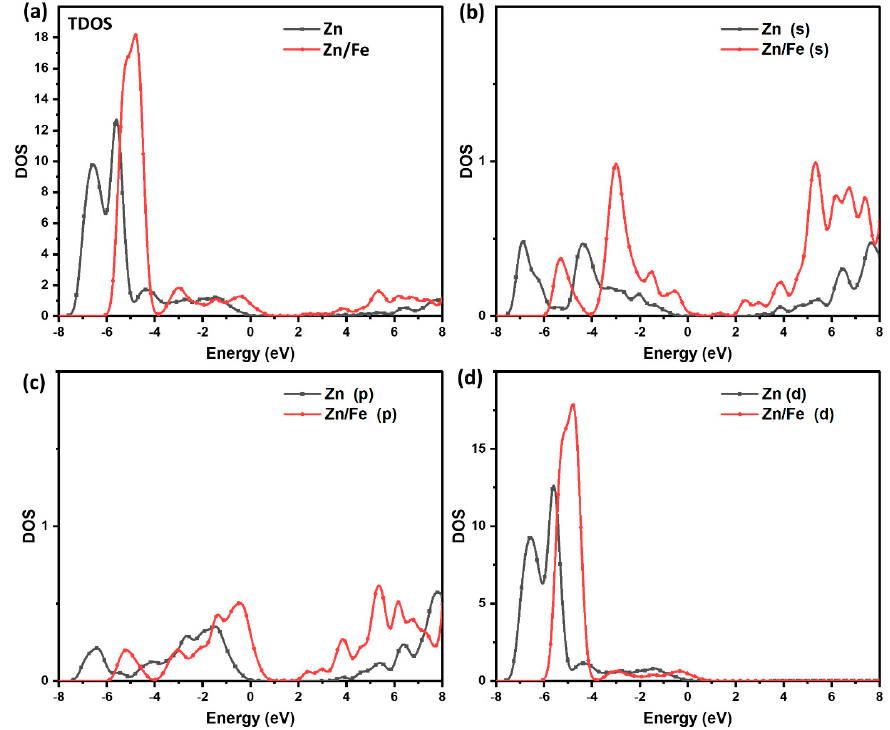
Figure 6. Calculated TDOS and PDOS of ZnO in comparison with 5%Fe doped ZnO, with TDOS-Zn ( a ); s-orbital contributions for Zn atom and doped 5%Fe@Zn (Zn/Fe) ( b ); p-orbital contributions ( c ); and d-orbital contributions ( d ).